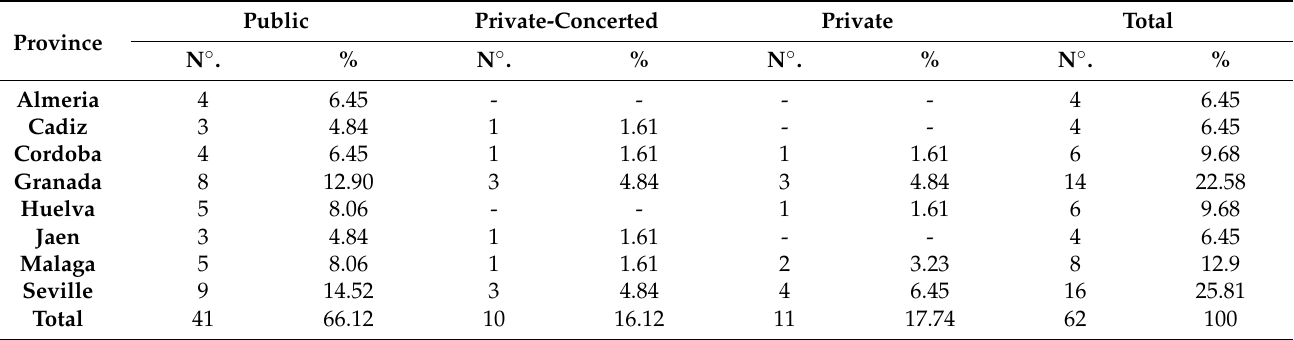
Table 1. Distribution of participants by province and ownership of the